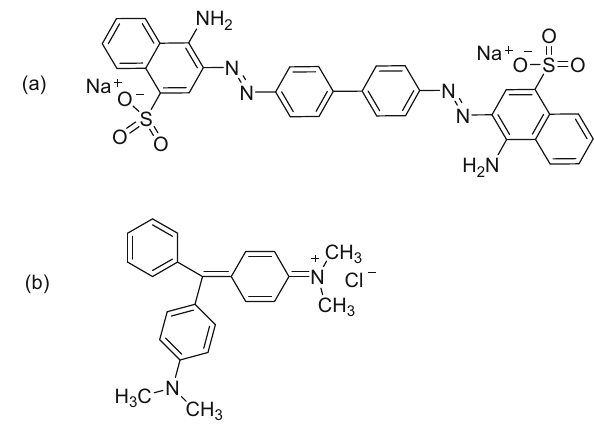
Figure 1: Chemical structures of ( a ) CR and ( b )